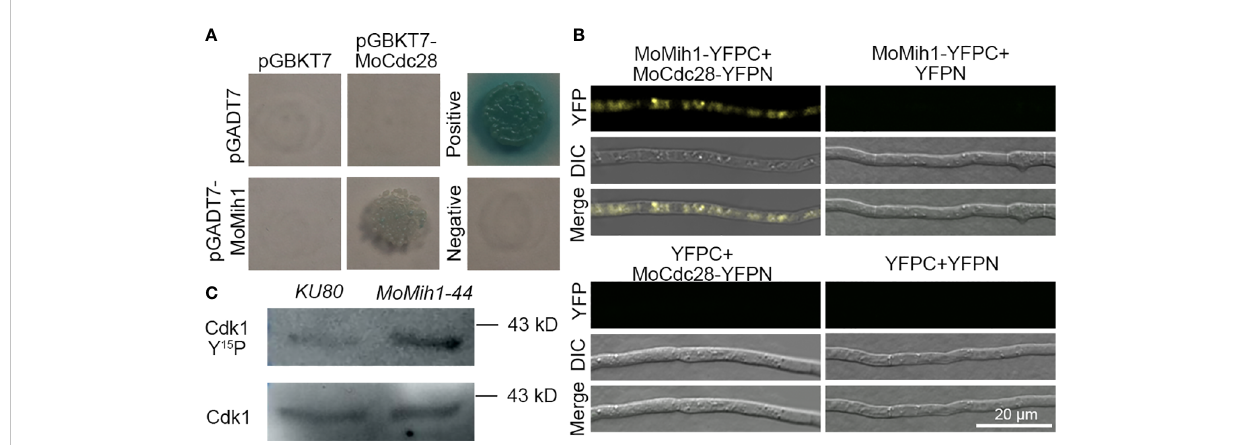
FIGURE 10 MoMih1 physically interacts with MoCdc28 and regulates the Cdk1 phosphorylation in M. oryzae (A) Yeast two-hybrid assay. The coding sequences of MoMih1 and MoCdc28 were inserted into the vector pGADT7 and pGBKT7, respectively, and then co-transformed into yeast strain AH109. Yeast cells co-transformed with pGADT7/pGBKT7-MoCdc28, pGADT7-MoMih1/pGBKT7, pGADT7-T/pGBKT7-53, and pGADT7-T/pGBKT7-Lam were used as control, respectively. (B) Detection of interaction between MoMih1 and MoCdc28 by bimolecular fl uorescence complementation (BiFC) assay. A pair of MoCdc28- N YFP and C YFP-MoMih1 constructs were co-transformed into wild type strain Guy11. Construct pairs of MoCdc28- N YFP and C YFP, C YFP-MoMih1 and N YFP, and N YFP and C YFP were co-transformed into Guy11 to serve as negative controls. YFP signals were detected under the CLSM. (C) Detection of the Cdk1 phosphorylation in the MoMih1 mutant. Western blot was carried out to detect Cdk1 Y 15 P (for phosphorylation signal) and Cdk1 in protein extracts using the anti-phospho-Cdc2 (Tyr15) and anti-Cdc2 antibodies, respectively. Note that the phosphorylation signal was intensi fi ed in MoMih1 deletion